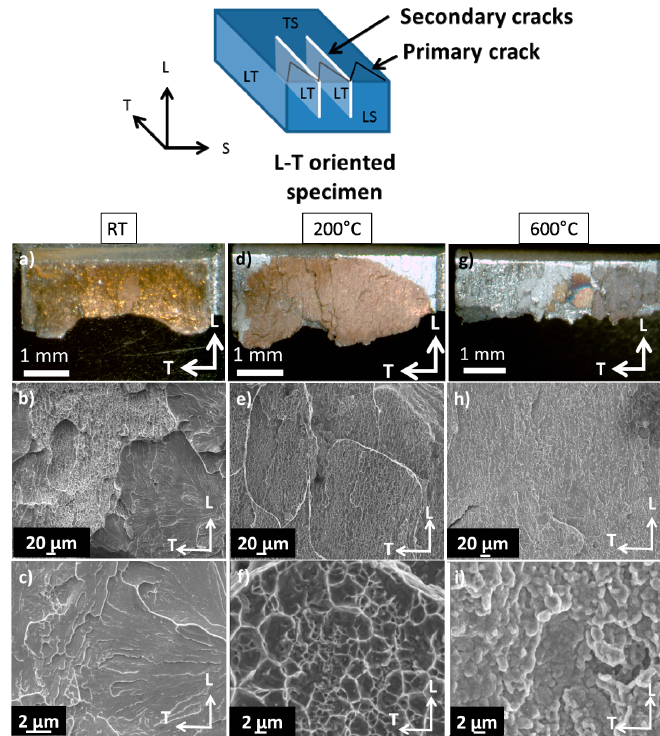
Figure 9. Stereo microscope and SEM images of secondary crack fracture surfaces of ODS-KIT HR at ( a – c ) RT, ( d – f ) 200 ◦ C and ( g – i ) 600 ◦ C for the L-T orientation. The notch is on the right of all